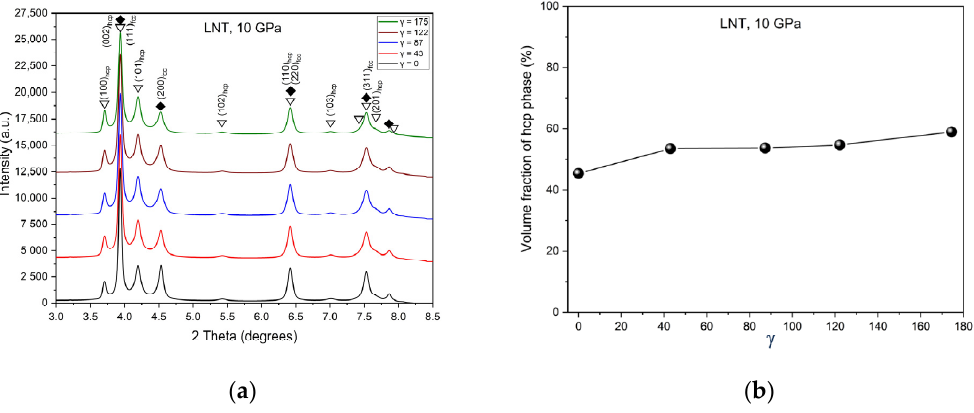
Figure 2. ( a ) X-ray diffractograms after HPT at LNT and 10 GPa for different shear strains γ clearly demonstrating the phase transformation. ( b ) Volume fraction of hcp phase as a function of shear strain.